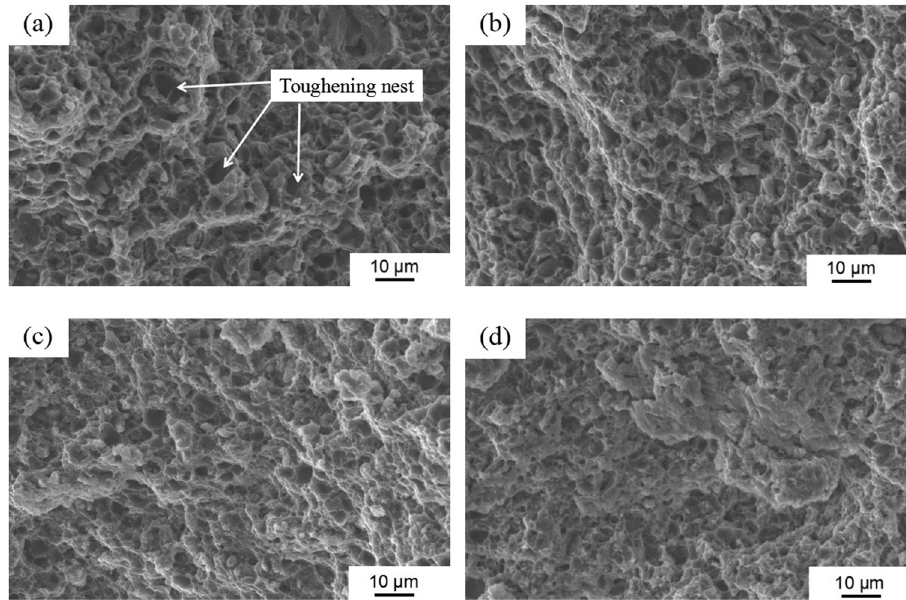
Figure 7: Fracture morphology of nanocomposites with di ff erent SiCp volume fractions: ( a ) 1% SiCp, ( b ) 2% SiCp, ( c ) 3% SiCp, and ( d ) 4%